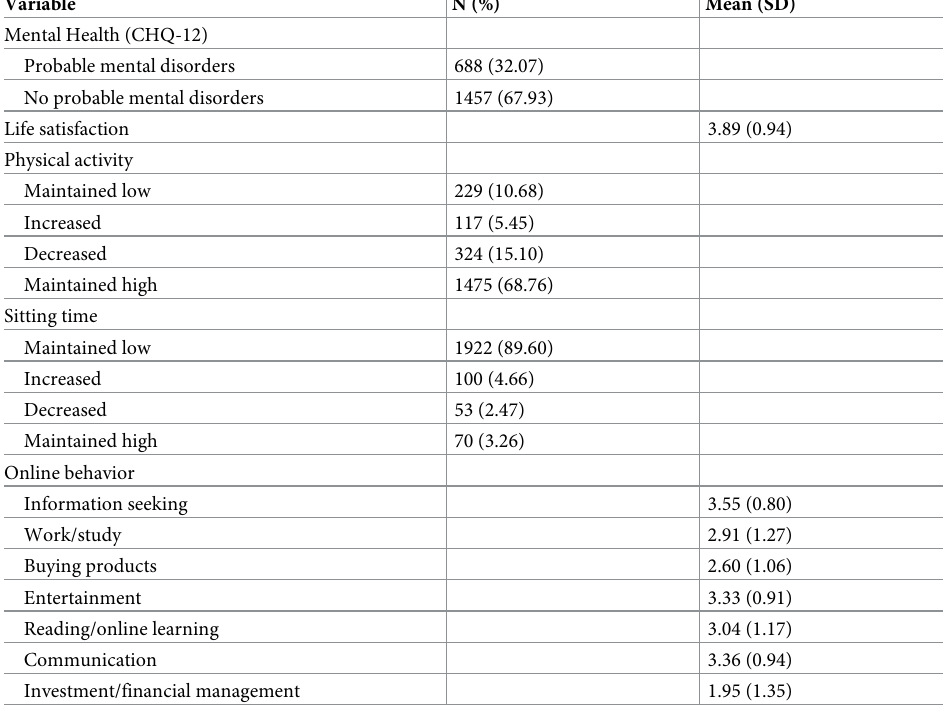
Table 2. Descriptive statistics of dependent and independent